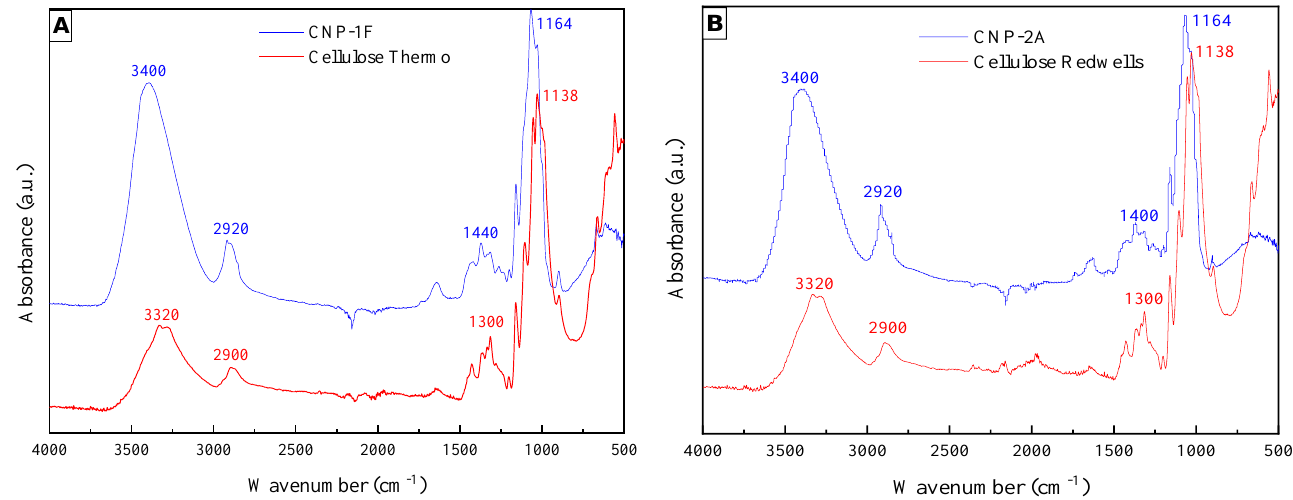
Figure 2. ATR − FTIR spectra of ( A ) CNP − 1F and cellulose Thermo, ( B ) CNP − 2A and cellulose Redwells. All four types of cellulose show broad absorption peaks [43], between 3320 and 3400 cm − 1 , assigned to hydrogen-bound -OH stretching vibrations. Peaks between 2900 to 2920 cm − 1 are associated with C-H stretching vibrations. In addition, the peaks near 1640 cm − 1 are attributed to the H-O-H deformation vibration of the absorbed water and the C = O conjugate stretching vibration. The absorbing band between 1300 and 1440 cm −